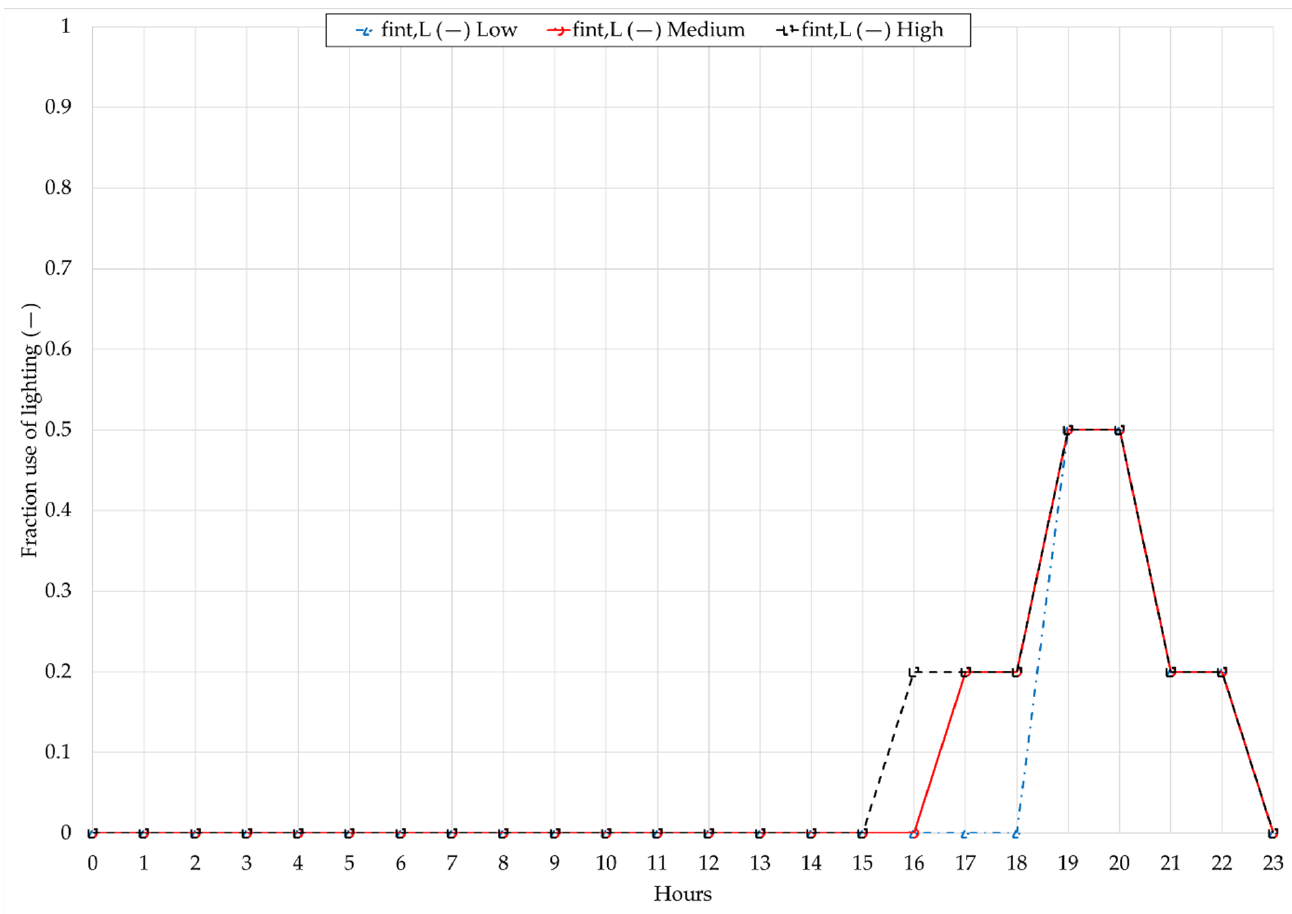
Figure 7. Fraction of appliance uses for the different scenarios analysed (low, medium, and high).